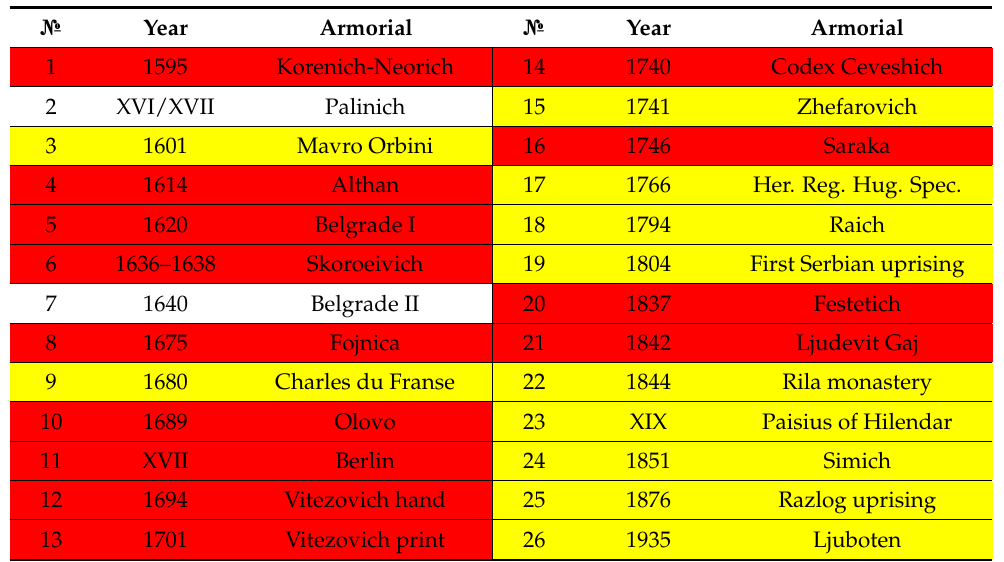
Table 1. The 26 sources processed by Matkovski (the coloring of the cell indicates the color of the shield, while the color of the lettering the color of the